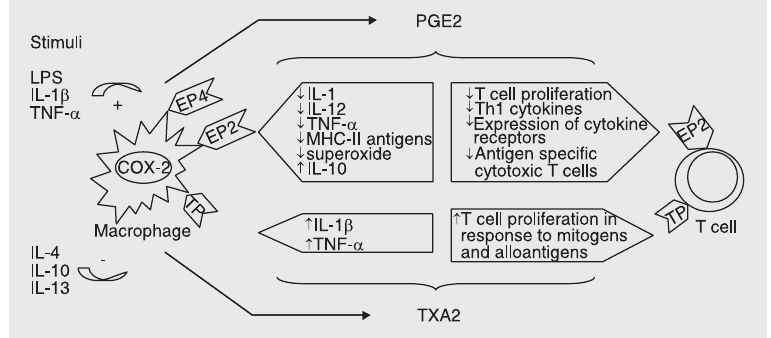
Figure 3. Effects of prostanoids on immune cells. Schematic drawing depicting the genera- tion of prostanoids by antigen-presenting cells (APCs), represented here by a macrophage, and the subsequent actions of these prostanoids on APCs and T cells. Inflammatory cytokines such as IL-1 and TNF- α up-regulate COX-2 in macrophages and thereby promote an increase in the output of prostanoids. The actions of PGE2 are mainly immunosuppres- sive. In macrophages, PGE2 causes an increase in the production of the anti-inflammatory cytokine IL-10 and a reduction in the production of pro-inflammatory cytokines and superox- ide, as well as a reduction in MHC class II antigen expression. These actions are mediated by EP2 and EP4 receptors. In T cells, PGE2 binds EP2 receptors and suppresses prolifera- tion, cytokine production and antigen-specific cytotoxicity. Conversely, TXA2 appears to stimulate both macrophage and T cell functions, effects that are mediated via a single TP receptor. In macrophages, TXA2 is known to increase the production of pro-inflammatory cytokines IL-1 and TNF- α . In T cells, TXA2 increases the proliferative responses to mito- gens and alloantigens. LPS = lipopolysaccharide; IL = interleukin; TNF- α = tumor necrosis factor α ; COX = cyclooxygenase; MHC = major histocompatibility complex; Th = T helper; PG = prostaglandin; TX =